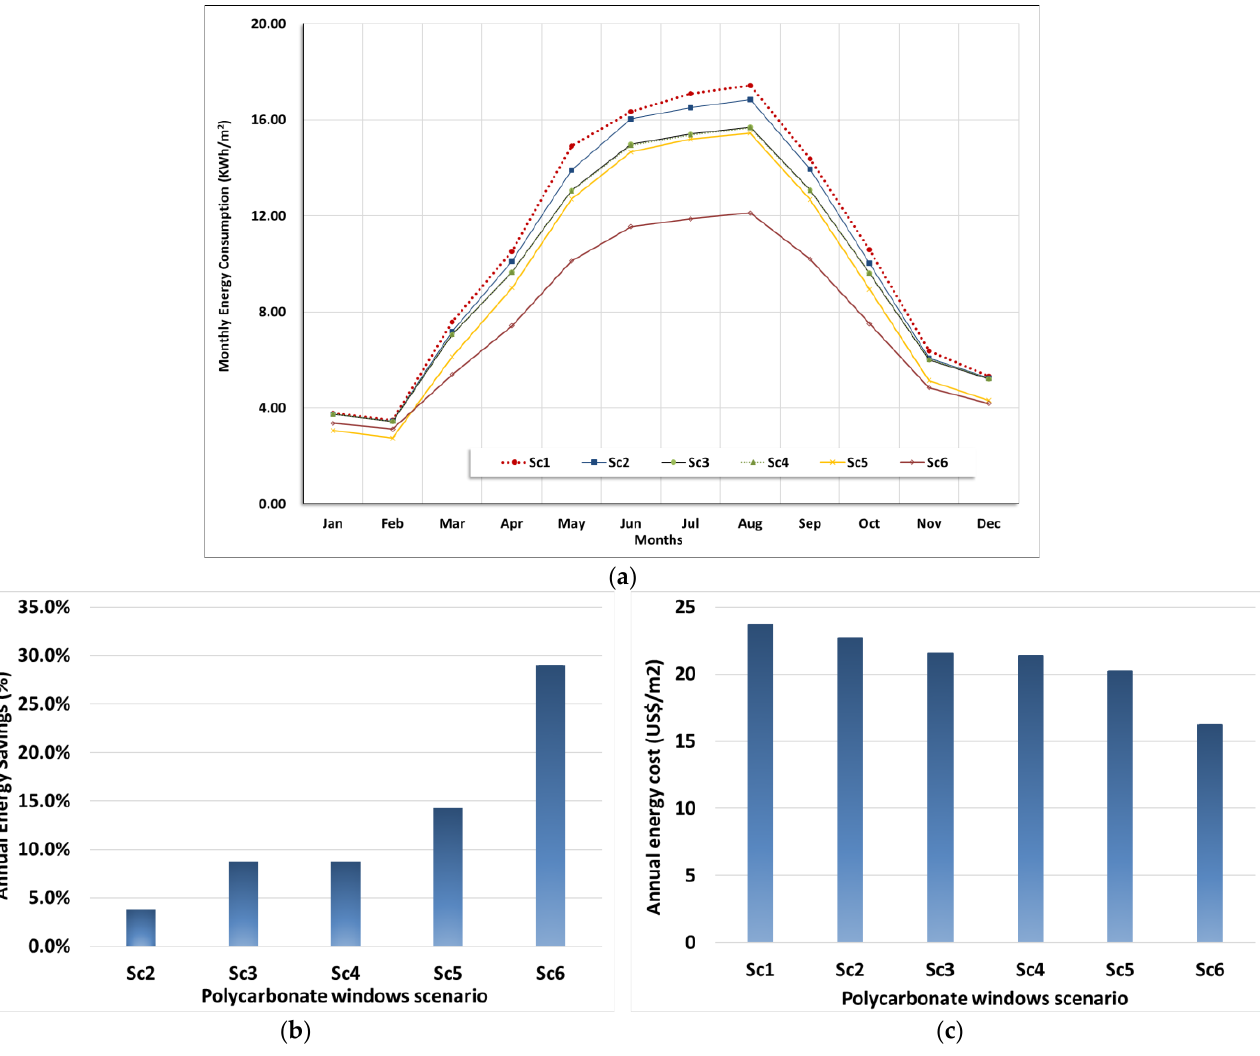
Figure 7. Simulation results for energy consumption attributed to the scenarios of polycarbonate windows: ( a ) monthly energy consumption; ( b ) annual savings; and ( c ) annual costs.